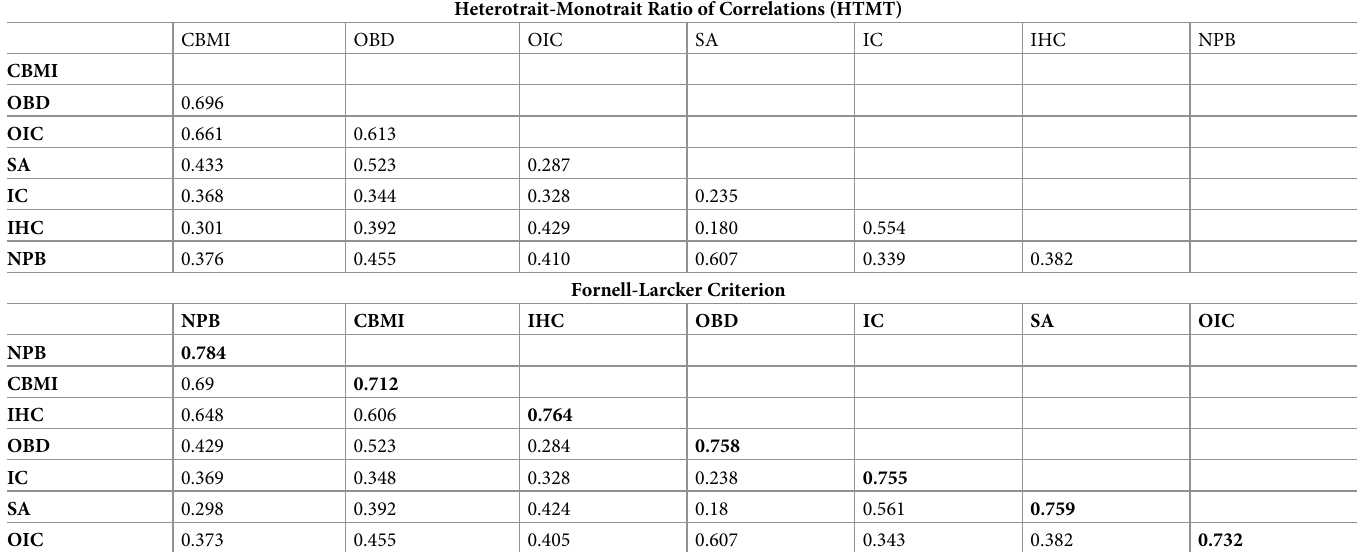
Table 4. Discriminant validity.